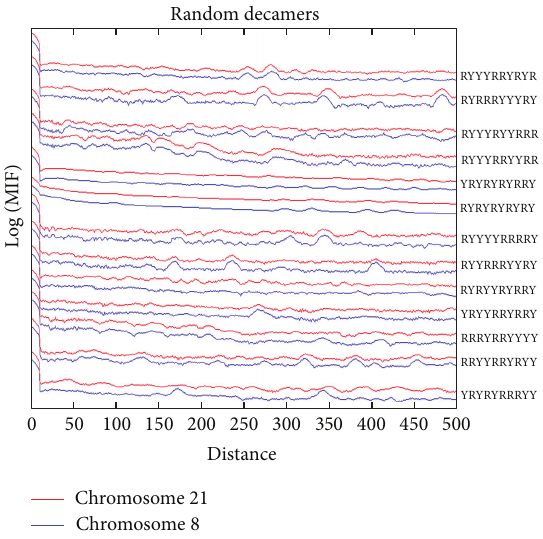
Figure 7: MIF profiles of random decamers with 5 purines and 5 pyrimidines along Homo sapiens chromosome 21, in order to compare the meaningful signal of YYYYYRRRRR as a binder nucleosome